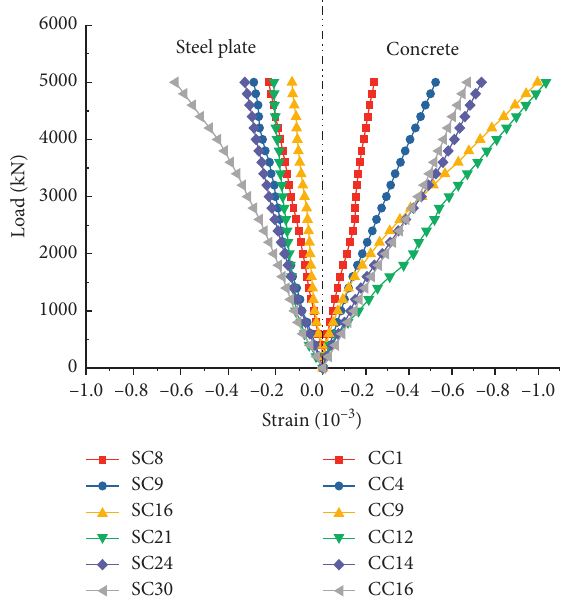
Figure 29: Load-strain relationship of SC-N2 in compressive experiment.